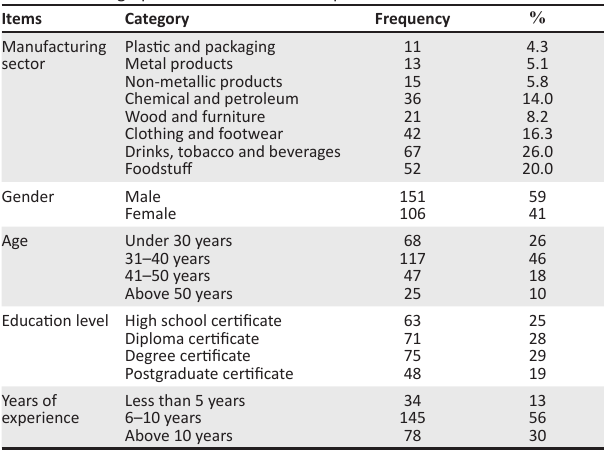
TABLE 1: Demographic characteristics of respondents.